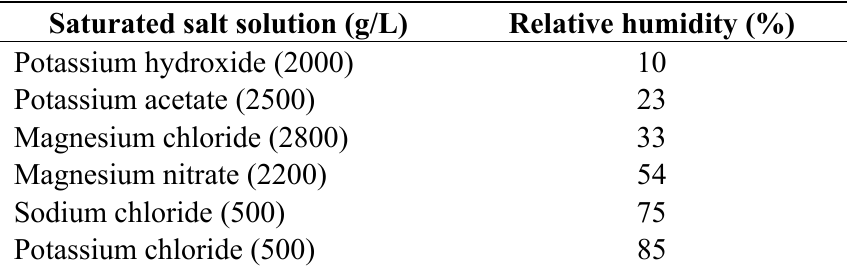
Table 4. Saturated salt solutions and equilibrium relative